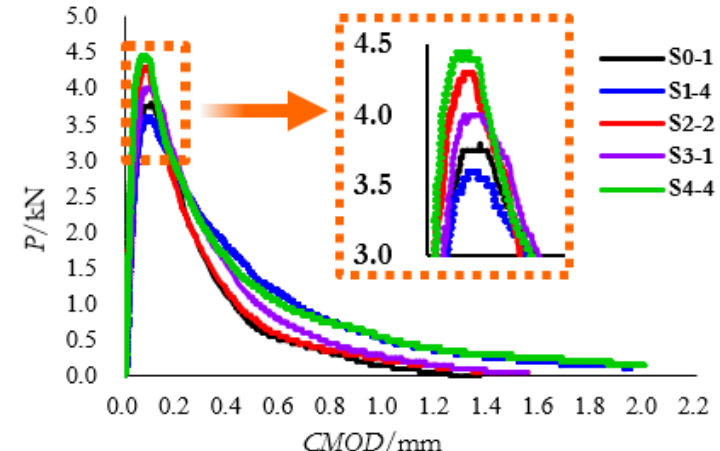
Figure 4: P-CMOD curves of some specimens